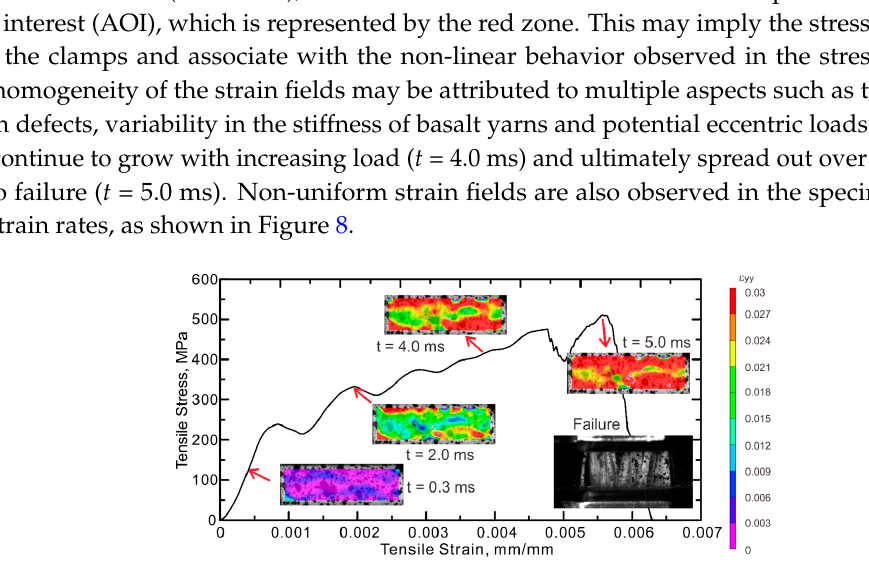
Figure 7. 2D contour of ε yy and stress–strain response for a GFRP specimen tested at the strain rate of 25 s − 1 obtained by digital image correlation (DIC).